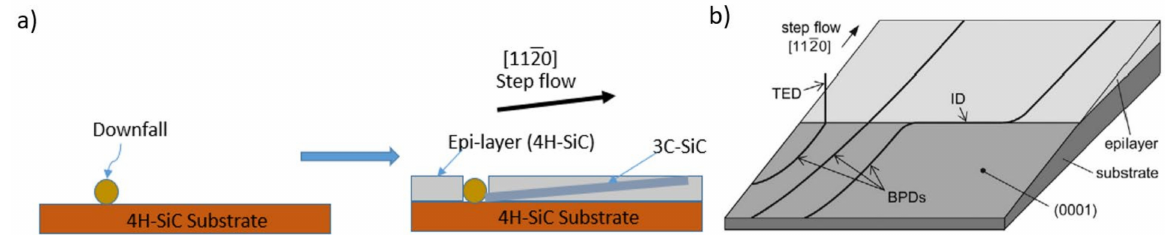
Figure 9. ( a ) Schematic illustration of the formation of downfall and ( b ) 3C-triangular defects and BPD propagation in 4H-SiC epitaxial growth [123].